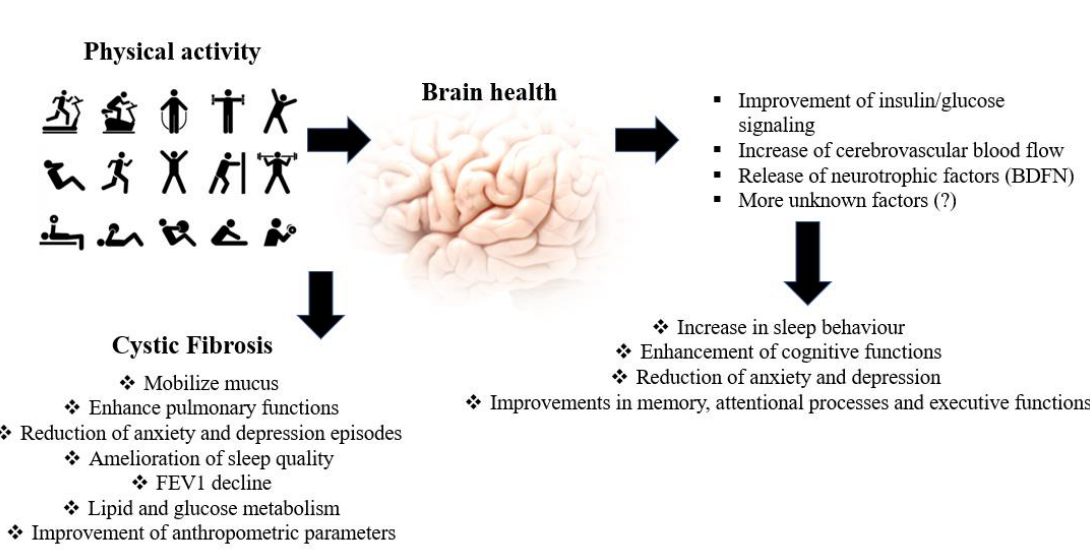
Figure 1. Effect of physical activity on Cystic Fibrosis patients (on the left) and on brain functions (on the right).